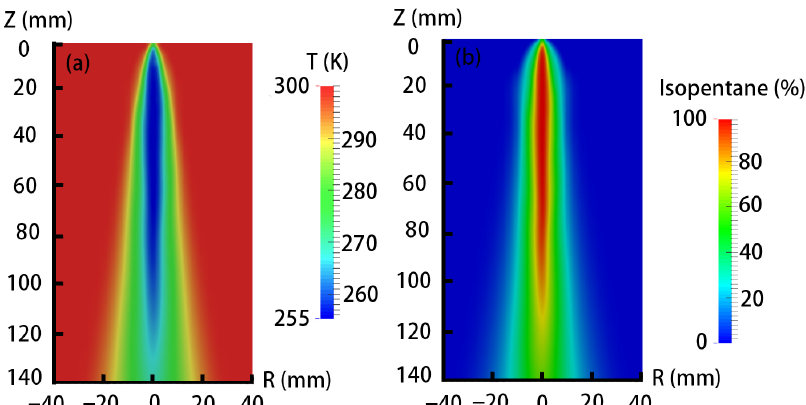
Figure 7. Temperature of gas phase and vapor concentration distributions of gas phase under the condition of initial injection temperature of 60 °C and pressure of 1.5 MPa. ( a ) Gas temperature distribution; ( b ) Vapor concentration distribution.